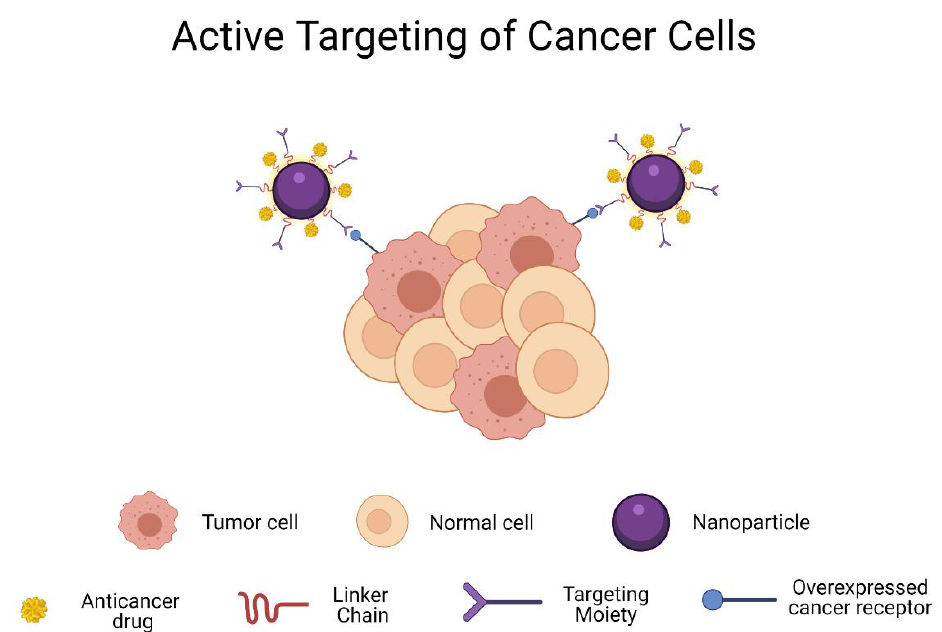
Figure 2. Schematic representation of active targeting of cancer cells by targeting moieties. Targeting moieties allow a specific binding with the overexpressed receptors on tumor cells. Created with BioRender.com.